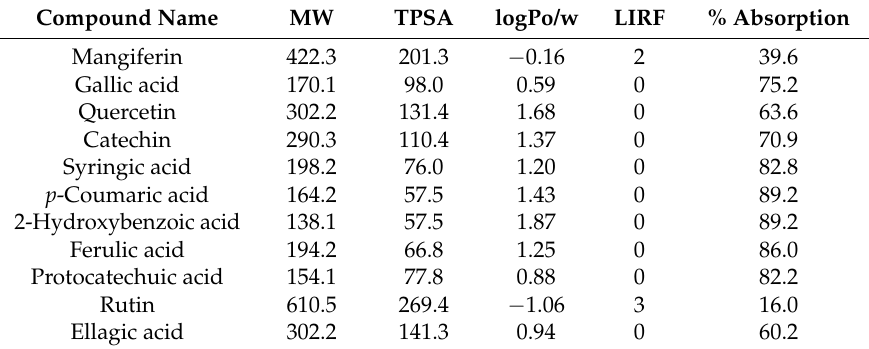
Table 3. Cheminformatics * of major polyphenol molecules from ‘Ataulfo’ mango